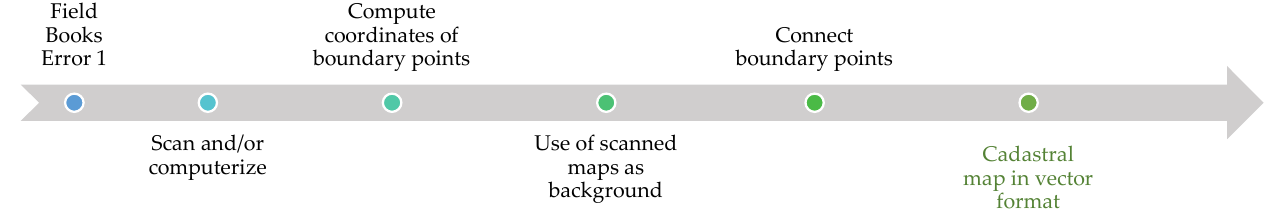
Figure 8. Workflow steps of revised digitisation process by respecting the importance of surveying field books.